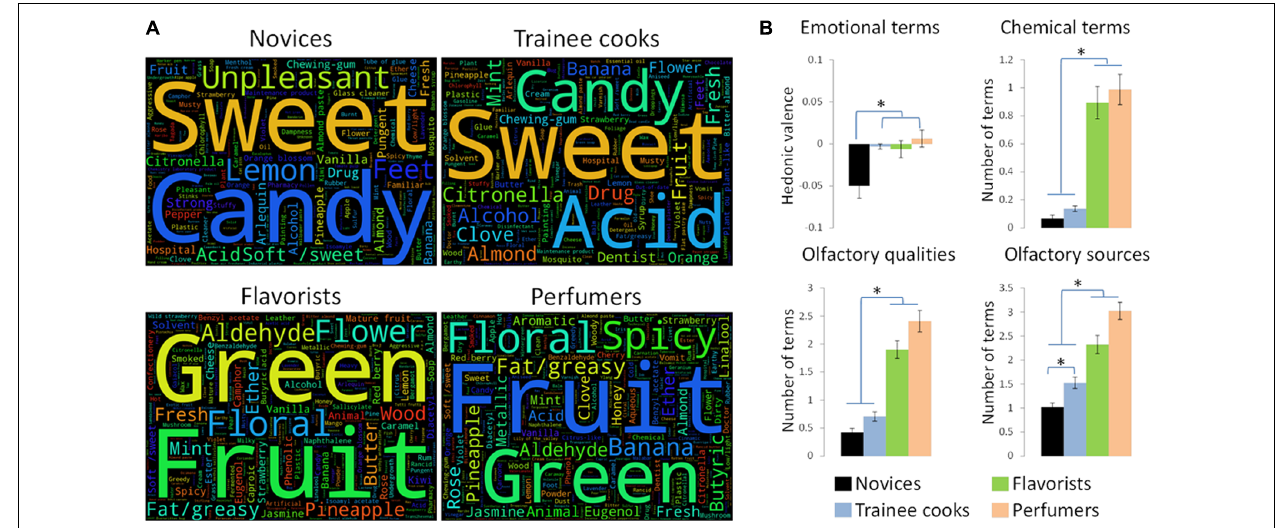
negatives. The number of chemical terms and olfactory qualities to describe odors is significantly higher in flavorists and perfumers than in novices and trainee cooks. Further, novices used less odor source references than trainee cooks, flavorists and perfumers and trainee cooks used less odor source references than flavorists and perfumers. * p < 0.05 (corrected for multiple comparisons).